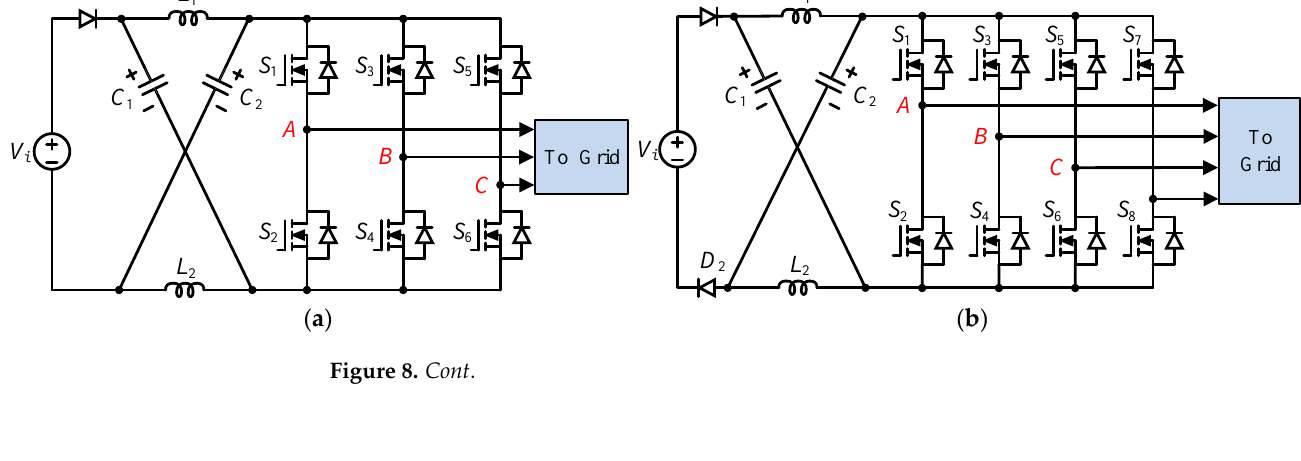
Figure 8. Passive impedance-source topologies for CMV reduction. ( a ) ZSI [71], ( b ) four-leg ZSI [72,73], ( c ) modified-ZSI [74,75], ( d ) qZSI [76,77].